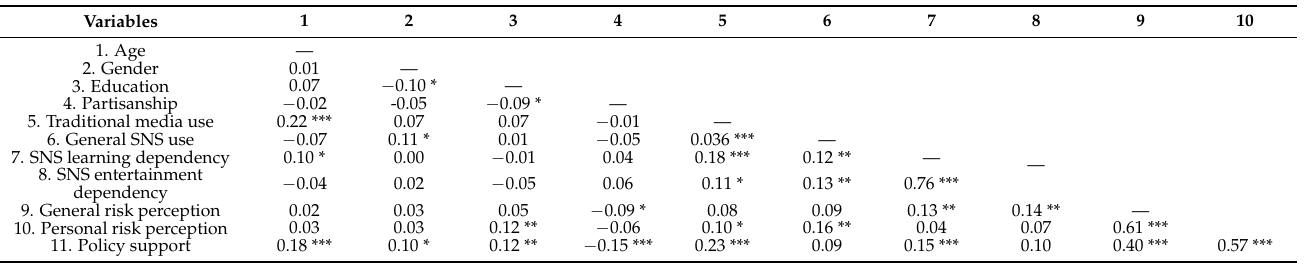
Table 1. Pearson correlations among the variables of this